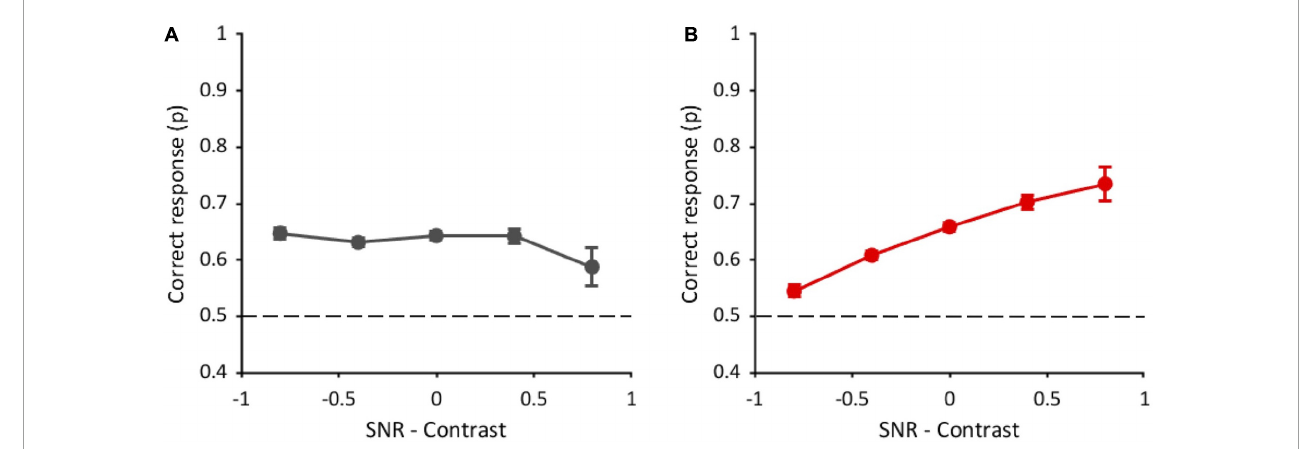
FIGURE6 Performance as a function of the difference between standardized SNR and contrast. (A) Task with original-contrast images. (B) Task with randomly inverted-contrast images. Data from all observers ( n = 10) and all conditions of visible area (7.5, 2, 0.75, and 0.2%) are pooled together. Errors are binomial standard deviation. Dashed lines represent chance